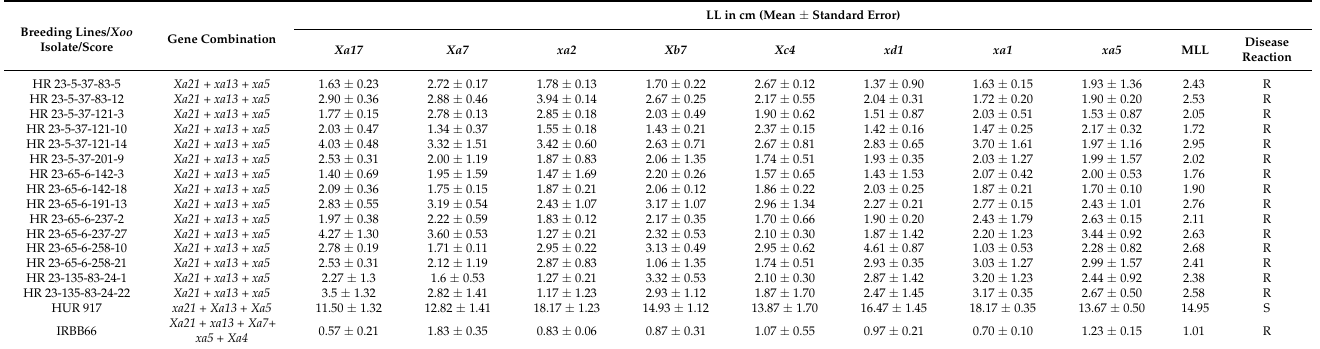
Table 4. Disease reaction (LL after 21 days of inoculation) of NILs (BC 2 F 3 ) carrying introgressed resistance genes in different combinations against 8 different races of Xoo